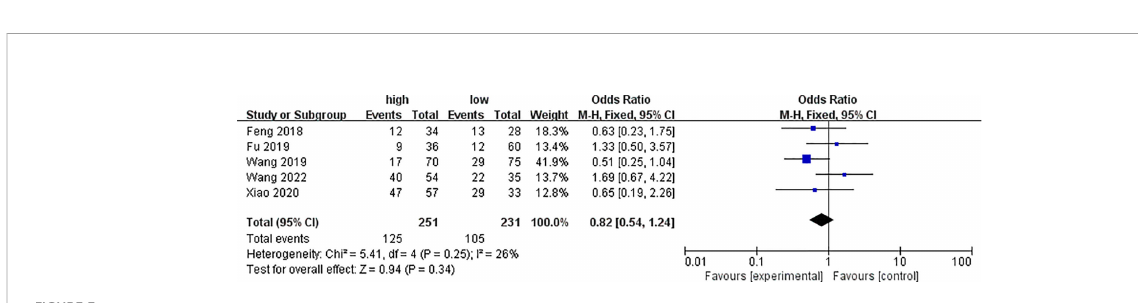
FIGURE 3 Forest plot of meta-analysis of the relationship between PYCR1 expression and cancer differentiation.